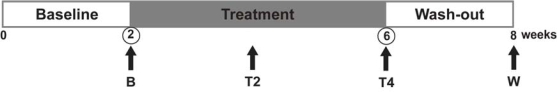
Experimental outline of the pilot study. Blood samples were taken at the times indicated by the arrows. Oral glucose tolerance test were performed at the times indicated by the circles.